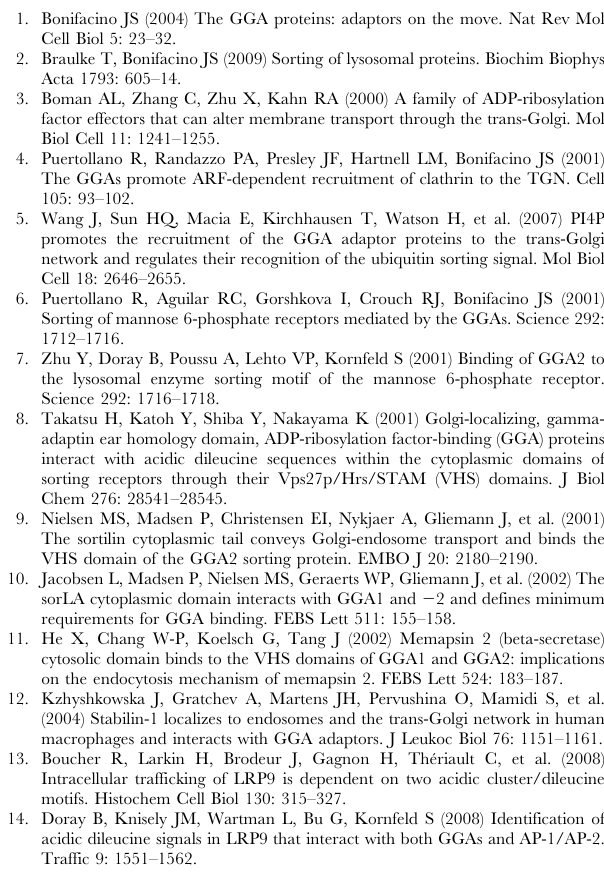
Figure S4 Production and testing of mouse-specific GGA3 pAb. A. Since none of the commercial anti-GGA3 antibodies specifically detected mouse GGA3 in western blot applications, mouse GGA3 (residues 1–345) was expressed in Sf9 insect cells, purified to homogeneity and used to immunize either Gga 3 2 / 2 or wt (control) mice for antibody production. This strategy elicited an antibody response in some of the Gga3 2 / 2 mice but none of the control animals. Western blot analysis of mouse brain lysates using the mouse polyclonal anti-sera showed that GGA3 expression was reduced in the Gga 3 + / 2 strain and ablated in the Gga 3 2 / 2 . There was also an additional band that migrated slightly above the 75 Kd marker that proved to represent cross- reactivity with GGA1, as shown in panel B. B. The lower band proved to be a GGA1 cross-reacting band, since it was absent in Gga1 2 / 2 and reduced in Gga1 + / 2 brain